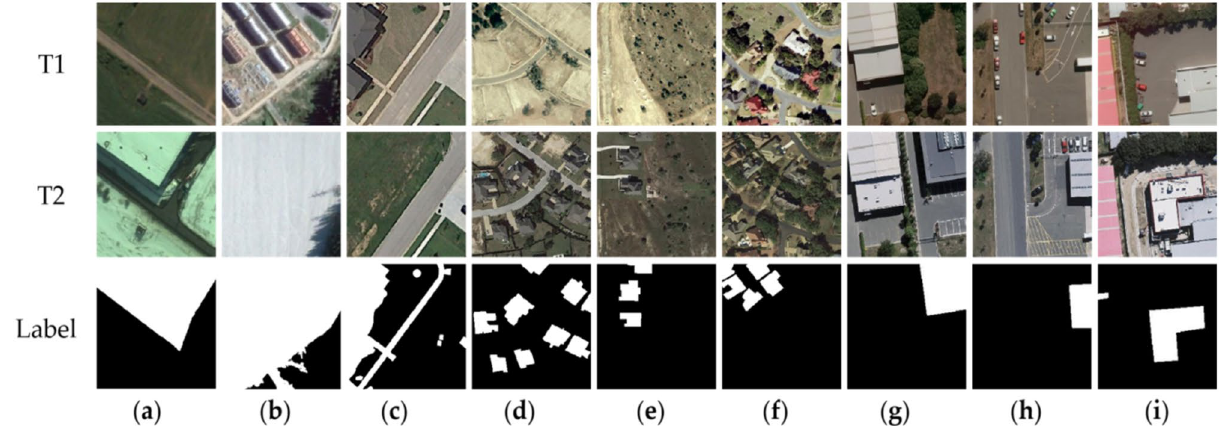
Figure 4. Bi-temporal remote sensing images from three open-source datasets CDD, WHU-CD and LEVIR-CD. The T1 are change before images, the T2 are change after images, the label represents the changed areas and the unchanged areas. ( a–c ) The images in the CDD dataset. ( d–f ) The images in the LEVIR-CD dataset. ( g–i ) The images in the WHU-CD dataset (created by ‘Microsoft Office Visio 2013’ url: https:// www.